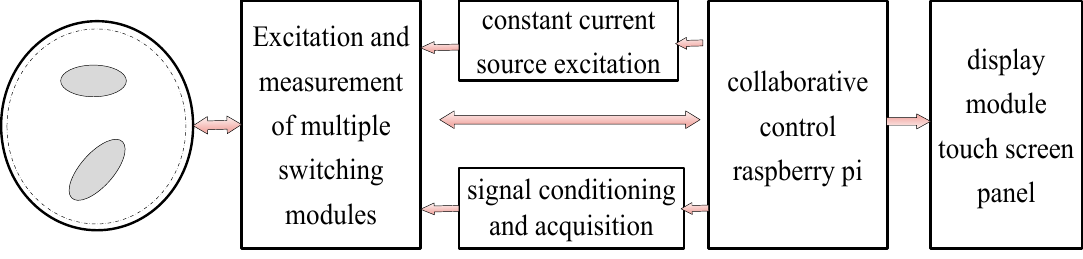
Figure 1. The diagram of the human pressure distribution acquisition system (HPDAS).